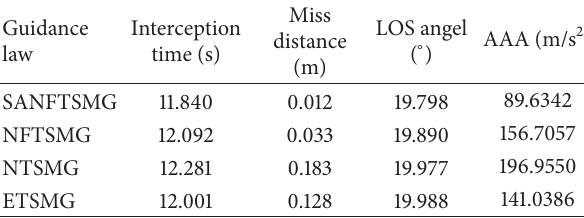
Table 7: Summary of simulation results in Case 3 .